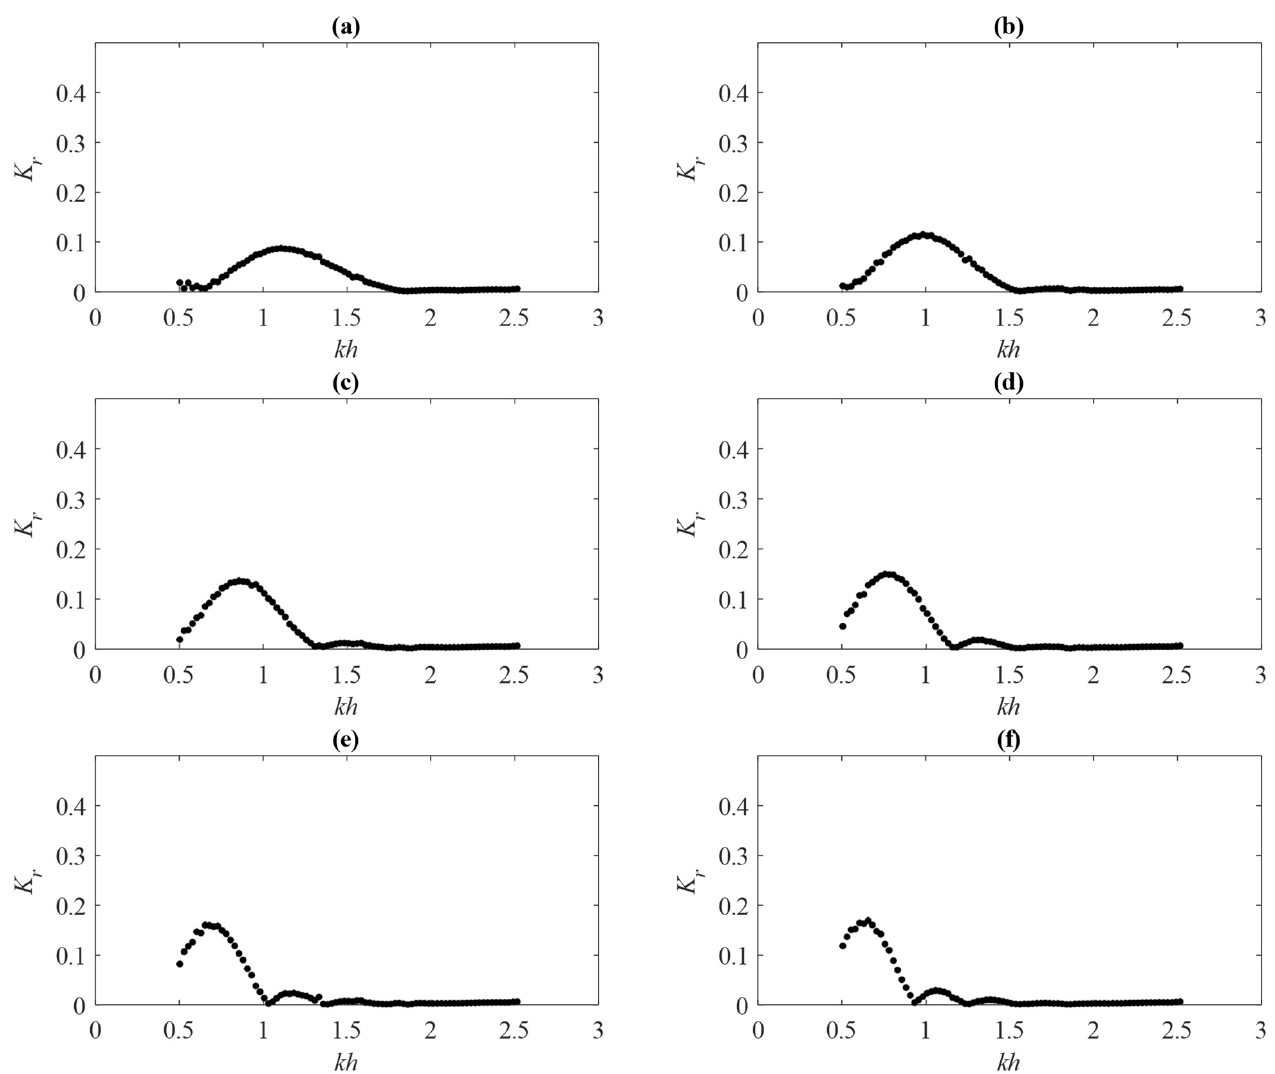
Figure 5. Reflection coefficient of 2 periodically submerged breakwaters with different structural wavelengths at 0.4 m water depth. ( a ) 𝑆 = 1.0 m ( b ) 𝑆 = 1.2 m ( c ) 𝑆 = 1.4 m ( d ) 𝑆 = 1.6 m ( e ) 𝑆 = 1.8 m ( f ) 𝑆 = 2.0 m.